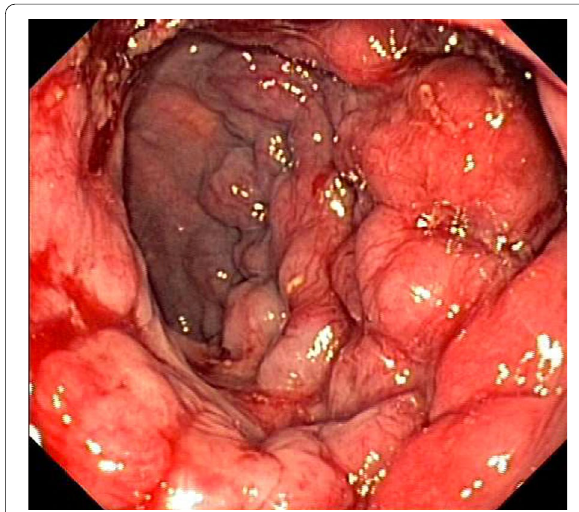
Fig. 1 The colonoscopy image shows dilated submucosal nodular lesions accompanied by edematous mucosal alterations